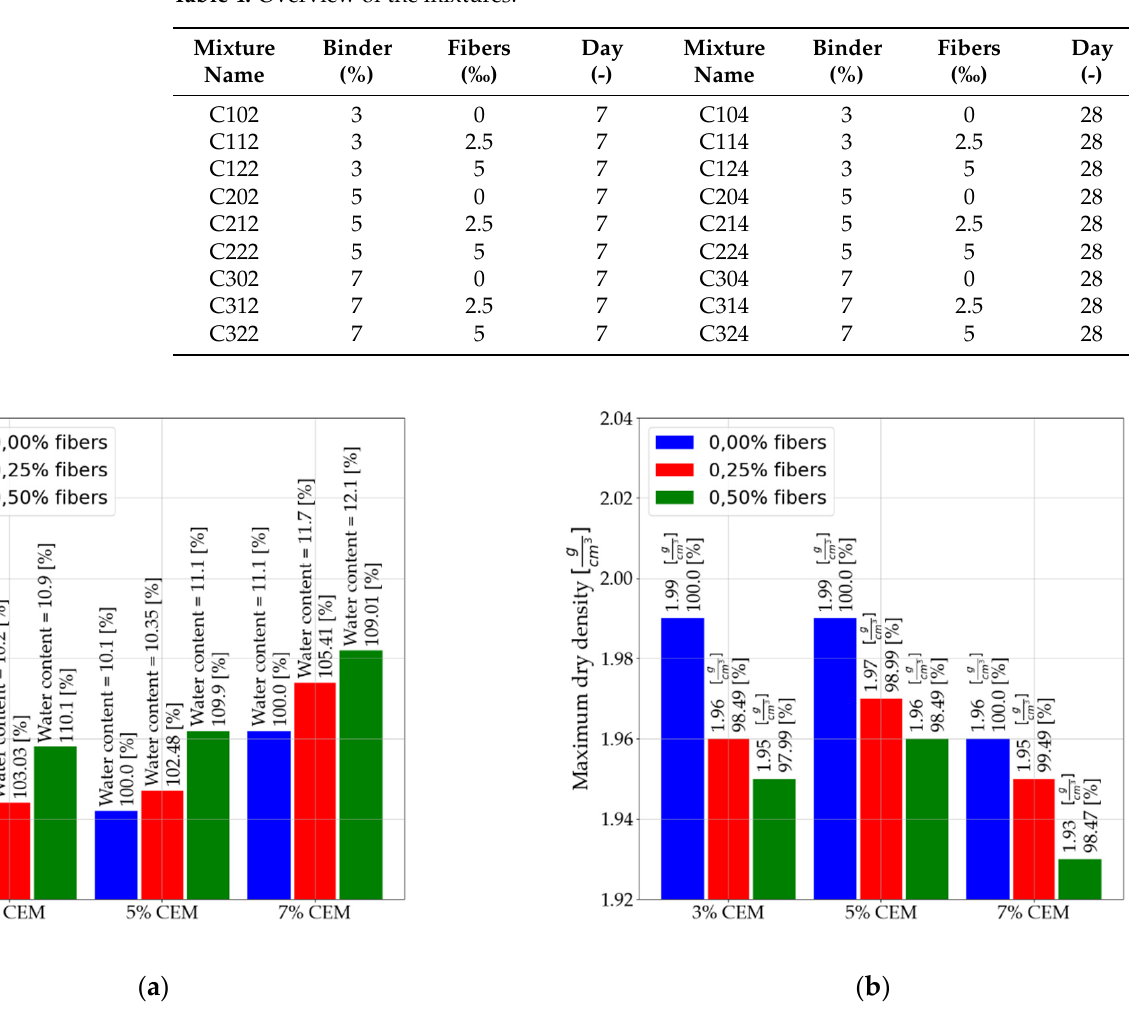
Table 4. Overview of the mixtures.